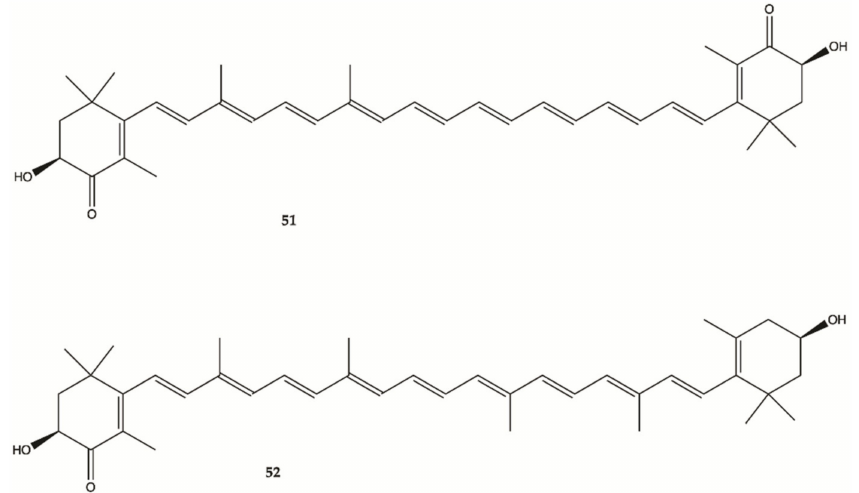
Figure 19. Astaxanthin ( 51 ) Adonixanthin ( 52 ) isolated from a red pigment